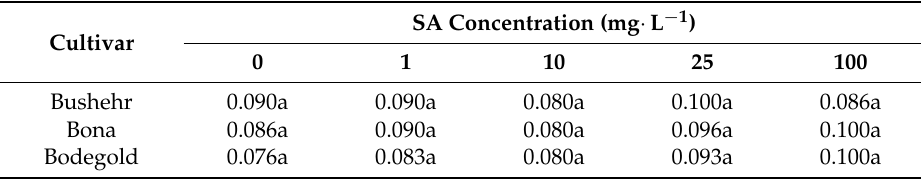
Table 12. Mean comparison for essential oil% ( w / w ) of chamomile treated with salicylic acid under heat stress